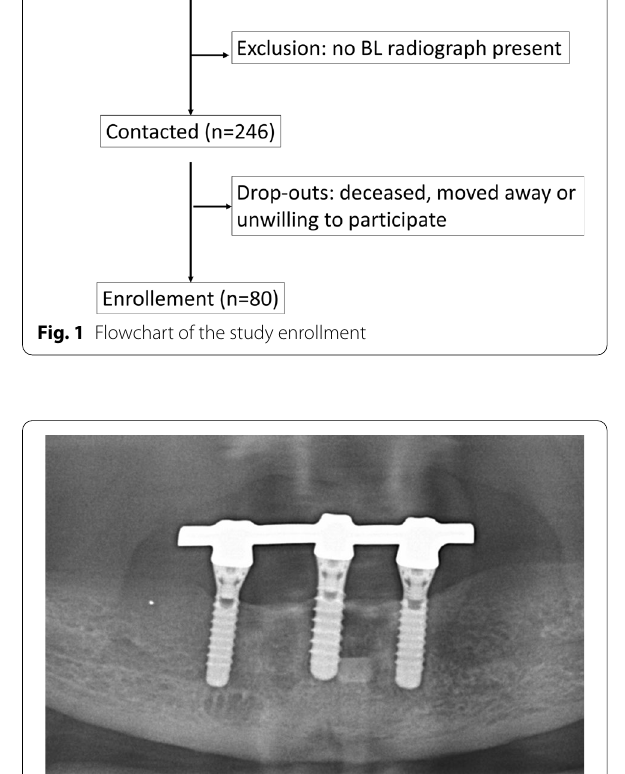
Fig. 2 Exemplary radiograph of the implant group HD‑SLA (Institut